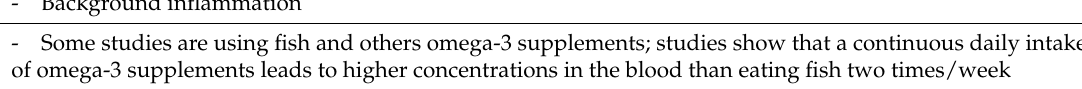
Table 2. Factors that affect outcomes in Obesity studies leading to conflicting results in clinical intervention trials (Modified from Reference